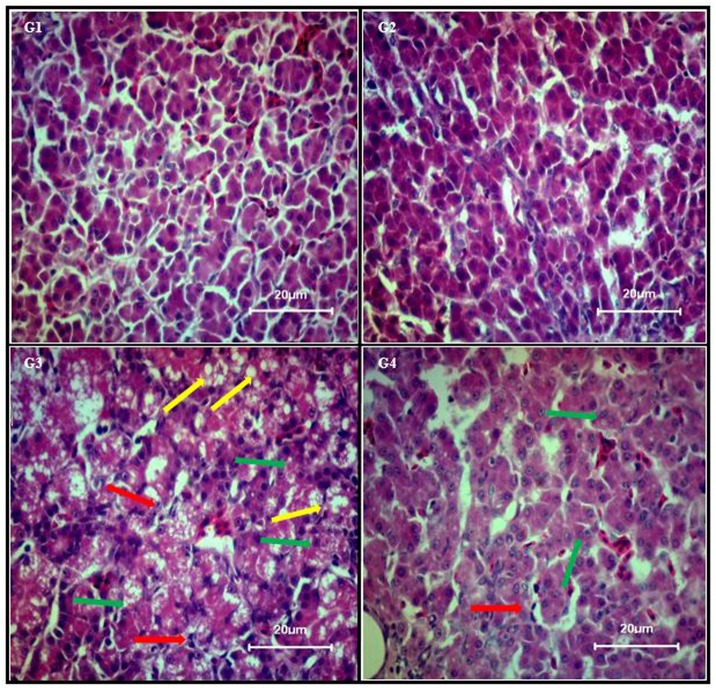
Chicken liver photomicrographs of hematoxylin and eosin-stained liver sections observed under light microscope (40X magnification), where n = 3 (H&E, scale bar = 20 μm). Treatments represented as (G1) control group; fed only basal diet, (G2) curcumin control group; basal diet + 450 mg curcumin/kg feed, (G3) AFB1 group; basal diet + 5.0 mg AFB1/kg feed, and (G4) curcumin+AFB1 group; basal diet + 5.0 mg AFB1 + 450 mg curcumin/kg feed. Yellow arrow, hepatic steatosis; red arrow, lymphocyte infiltration; and green arrow, hepatic granular degeneration.